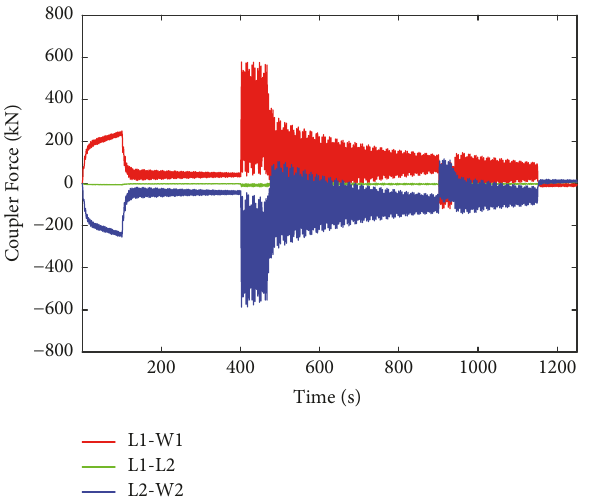
Figure 10: The coupler force among vehicles in Scenario B.